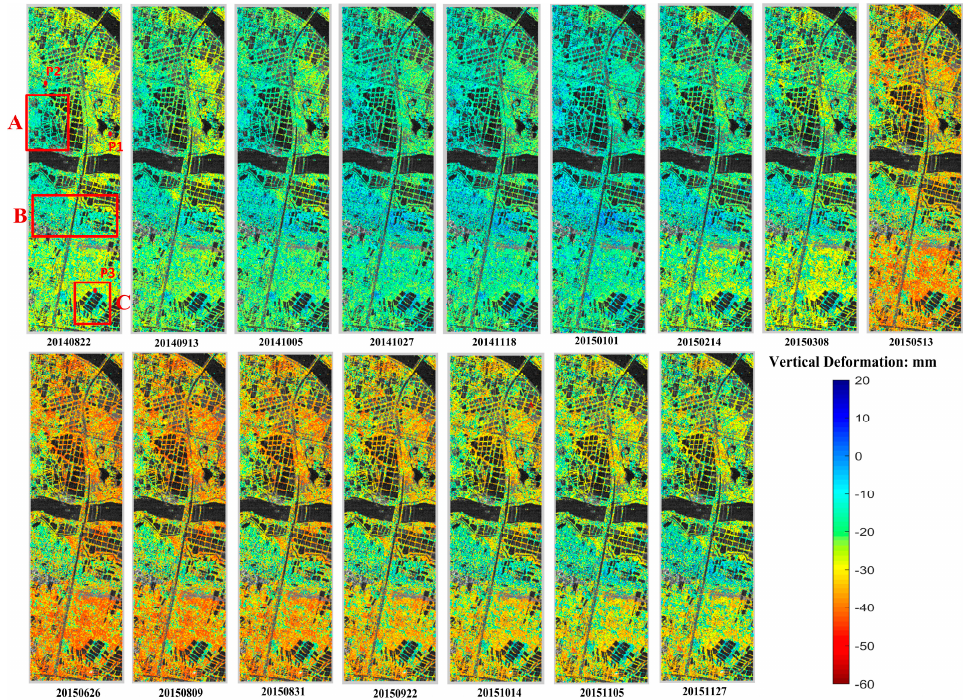
Figure 15. Time series of deformation images produced by SM over the Lungui Highway area (referenced to 2014/06/17, in slant-range projection).